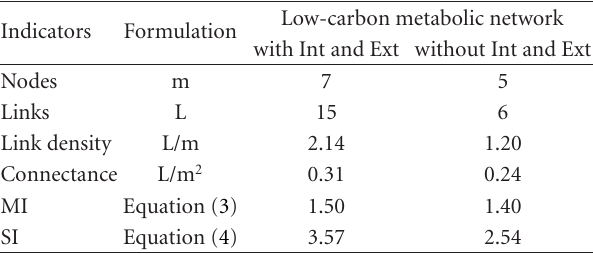
Table 4: System-wide indicators of carbon metabolism in BDA. Indicators Formulation